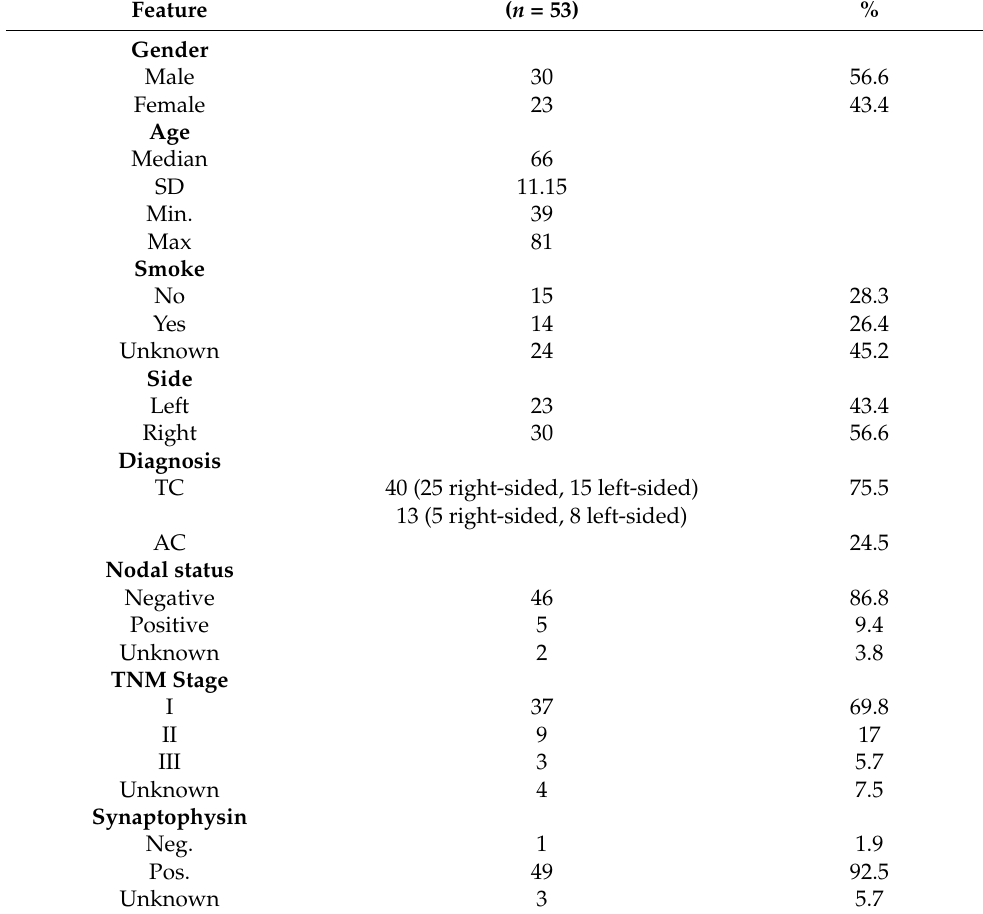
Table 1. Patient